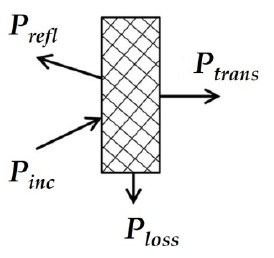
Figure 30. Scheme of power balance in the interaction of EMR with the sample.